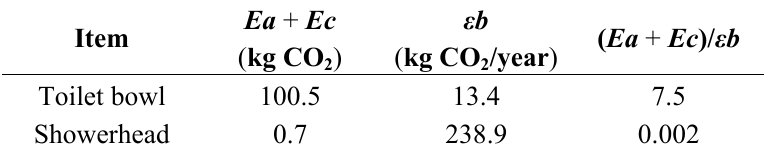
Table 2. Environmental impacts of toilet bowls and showerheads.